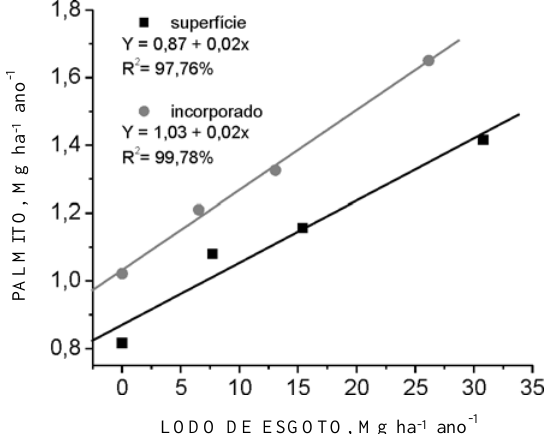
Figura 3. Produção anual de palmito considerando as doses de lodo de esgoto aplicadas anualmente, em superfície ou incorporadas, durante a fase de manutenção da cultura da